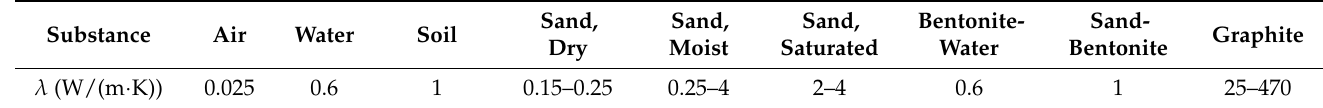
Table A1. The exemplary materials and their thermal conductivity.